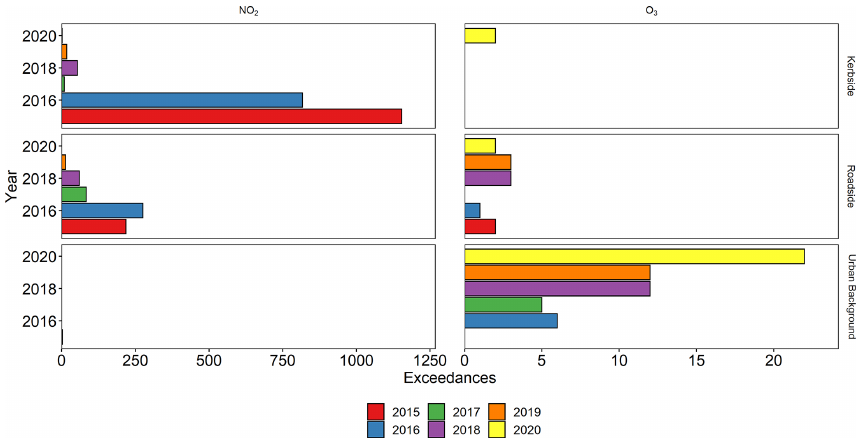
Figure 10. Exceedances of the UK air quality objectives for NO 2 and O 3 across the London Air Quality Network.